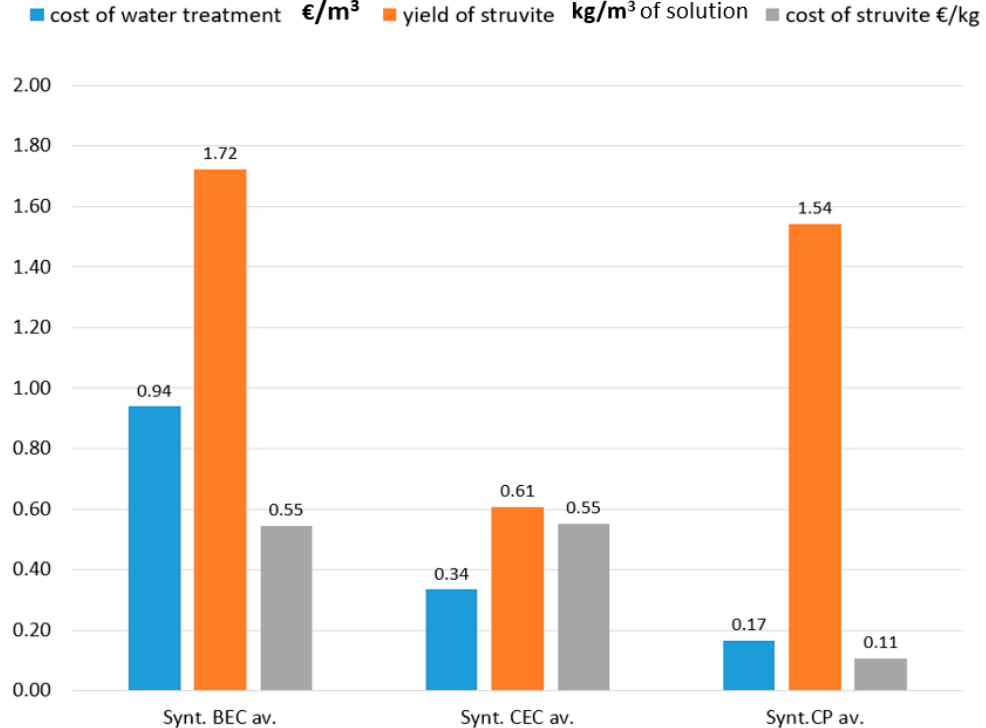
Figure 7. Average operational cost, struvite yield, and cost of 1 kg of struvite in the BEC, CEC, and CP in the SWT. BEC av., batch electrocoagulation average value; CEC av., continuous electrocoagulation average value; and CP av., chemical precipitation average value.